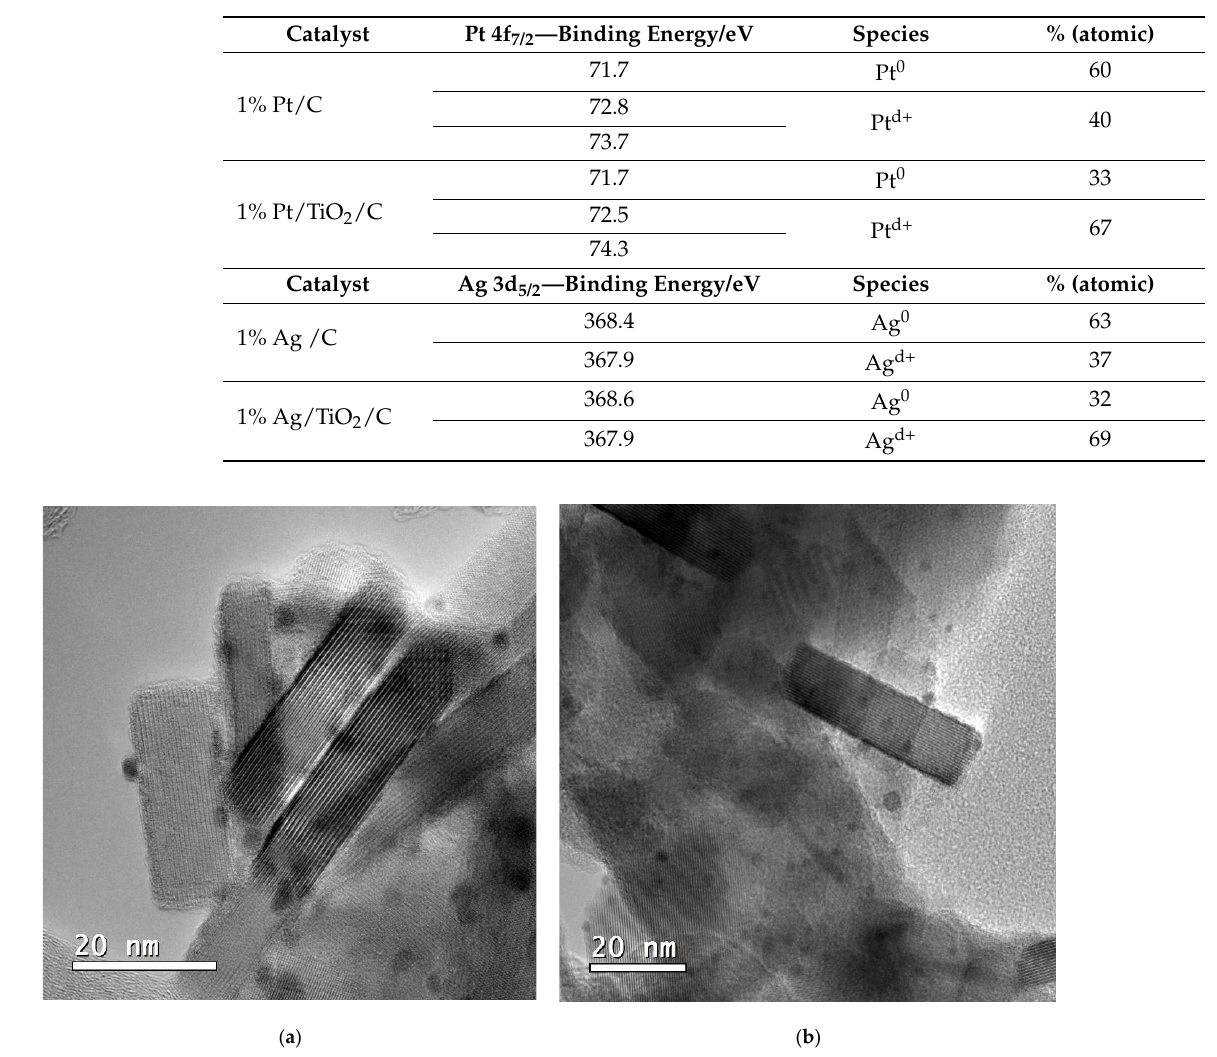
Table 2. Results obtained from XPS analyses.